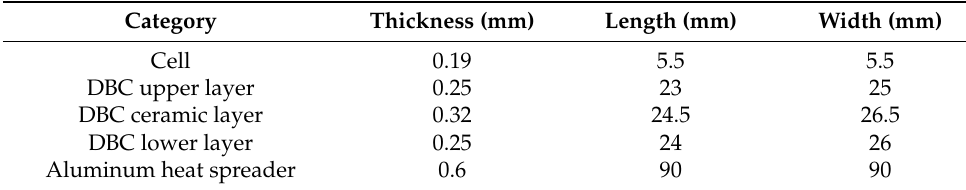
Table 1. Parameters of each layer material of the